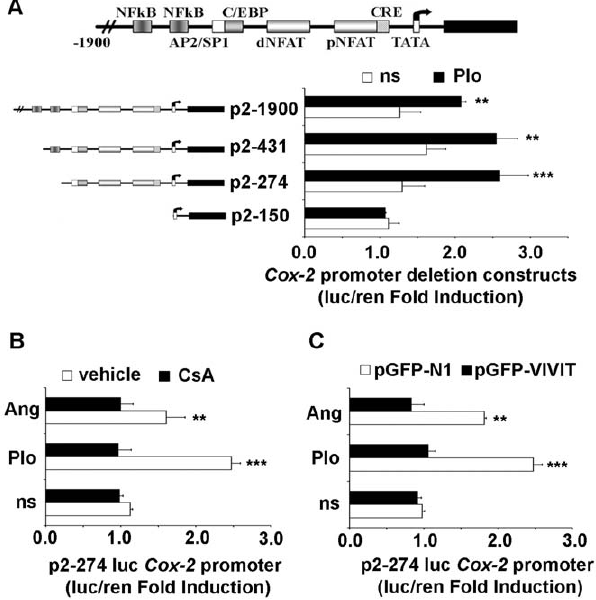
Figure 4. Inhibition of CN and endogenous CN-NFAT binding blocked Cox-2 gene promoter activation in primary ESC. (A) ESC isolated from uteri of non-pregnant rats were transiently transfected with a series of luciferase reporter plasmids containing regions of the human Cox-2 promoter starting from 2 1900 down to 2 150 upstream of the transcription initiation site. The schematic representation of the proximal 1900 bp region of the human Cox-2 gene promoter, showing the positions of putative transcription factor response elements [22] is embedded. Cell cultures were co-transfected with Renilla plasmids to normalize for transfection efficiency. Transfected cells were treated for 4 h with vehicle (ns, open bars) or PIo (solid bars), and the luciferase activity determined in cell lysates. Transcriptional activity is expressed as the fold increase in luciferase activity above baseline levels from transfected, nonstimulated control cells. (B) ESC transfected with the 2 274 Cox-2 luciferase reporter construct were pretreated for 1 h with vehicle (open bars) or 200 ng/ml of CsA (solid bars) and treated for 4 h with PIo or 500 nM of Ang II as indicated. Data are presented as in A. (C) Primary stromal cells isolated from uteri of non-pregnant rats were transfected with 800 ng of expression constructs encoding either pEGFP-VIVIT (solid bars) or pEGFP-N1 as control (open bars). Transfected cells were stimulated as before for 4 h with PIo, Ang II, or left untreated (ns), and the luciferase activity determined in cell lysates. Data are presented as in A. (A–C) Results shown are from a representative experiment of three performed, and values are the means 6 SD of triplicate determinations. *** P , 0.001; ** P , 0.01 (ANOVA).